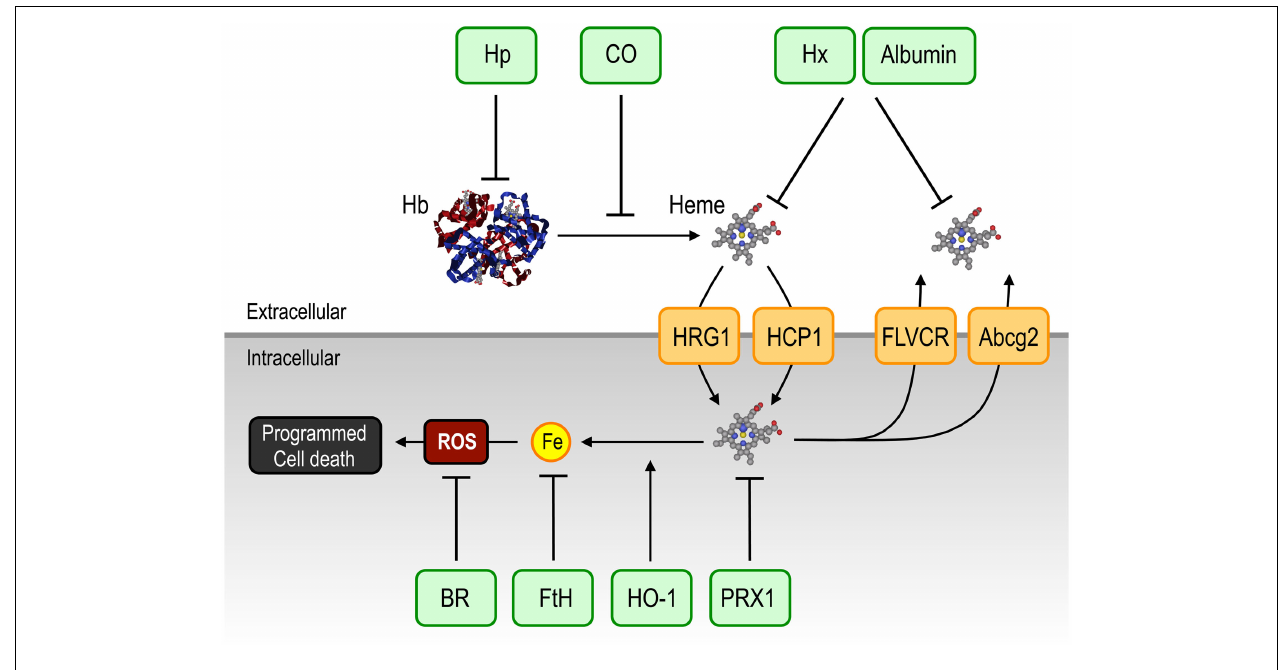
Specific heme transport between the intra- and extracellular compartments, including Abcg2, FLVCR, HCP1 and HRG-1, might be considered as potential, therapeutic targets to afford protection against heme cytotoxicity. Abbreviations: Bcrp/Abcg2, breast cancer resistance protein/ATP-binding cassette g2; BR, bilirubin; CO, carbon monoxide; Fe, iron; FLVCR, feline leukemic virus receptor; FtH, ferritin; Hb, hemoglobin; HCP1, heme carrier protein-1; Hp, haptoglobin; HO-1, heme oxygenase-1; HRG-1, heme responsive gene-1; Hx, hemopexin; ROS, reactive oxygen